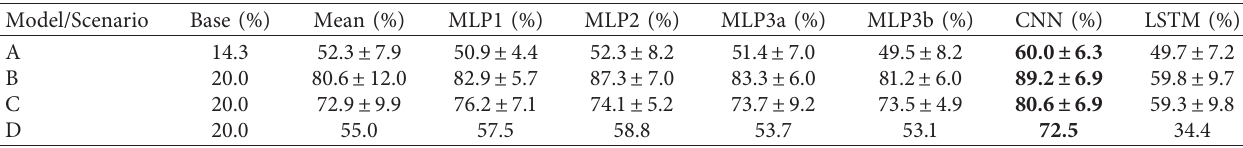
Table 6: Mean accuracy (with standard deviation if applicable) for different neural network models and different scenarios. Baseline (random) accuracy is denoted as “Base.” Visualization of this table is shown in Figure